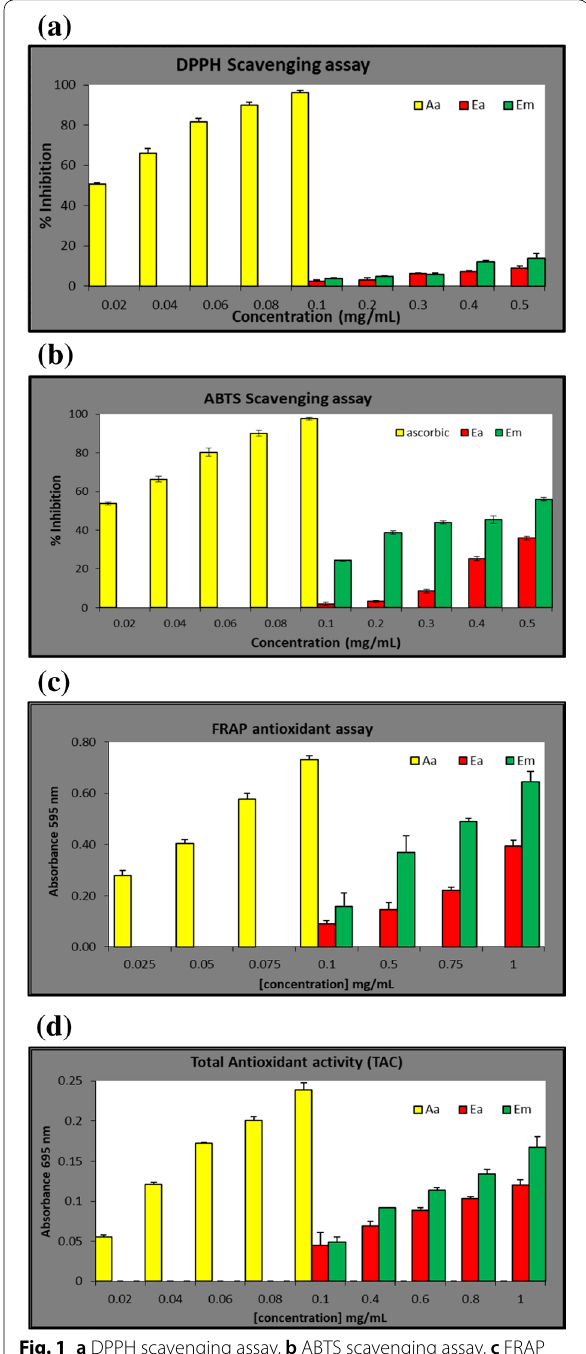
Fig. 1 a DPPH scavenging assay, b ABTS scavenging assay, c FRAP assay, d TAC